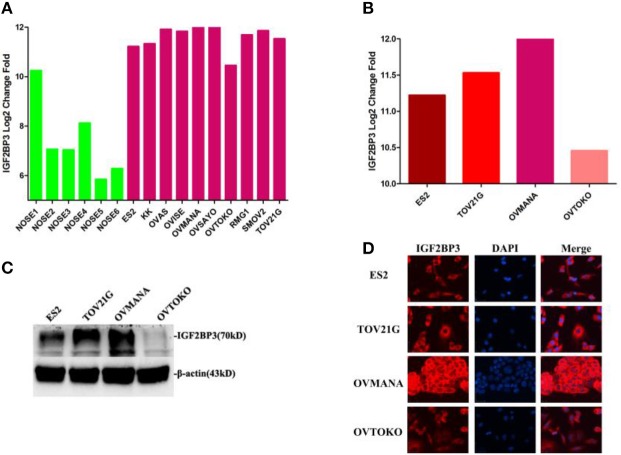
Expression levels of IGF2BP3 in OCCC cell lines and normal ovarian cells. (A) IGF2BP3 gene expression profiles of 6 independent NOSE cultures and 10 ovarian clear cell lines in GSE16570. (B) IGF2BP3 gene expression profiles in four specific OCCC cell lines. (C;
Supplementary Figure 2) The protein expression levels of IGF2BP3 in four OCCC cell lines. (D) IGF2BP3 localizes in cytoplasm of OCCC cells by immunofluorescence.